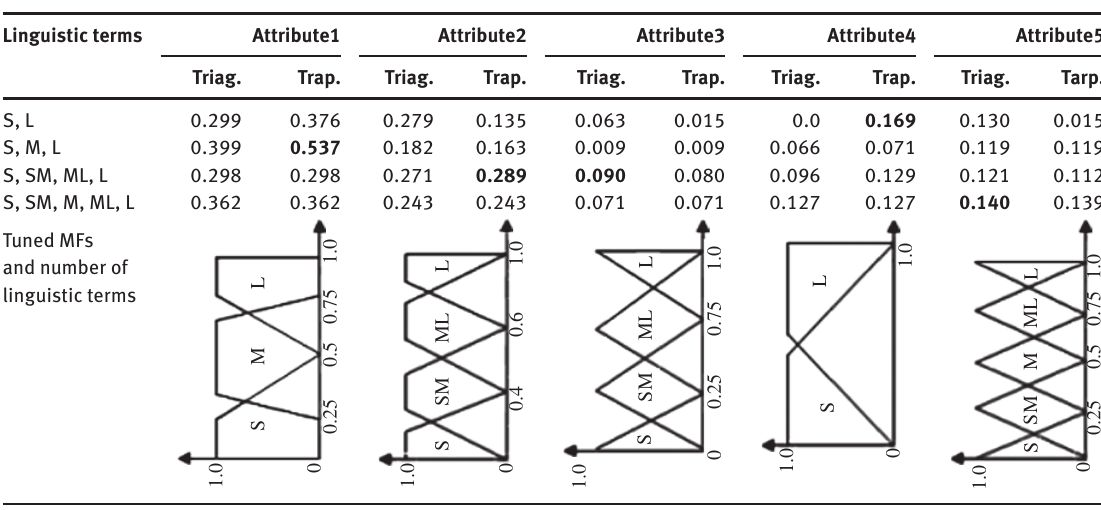
Triang., Triangular; Trap.,